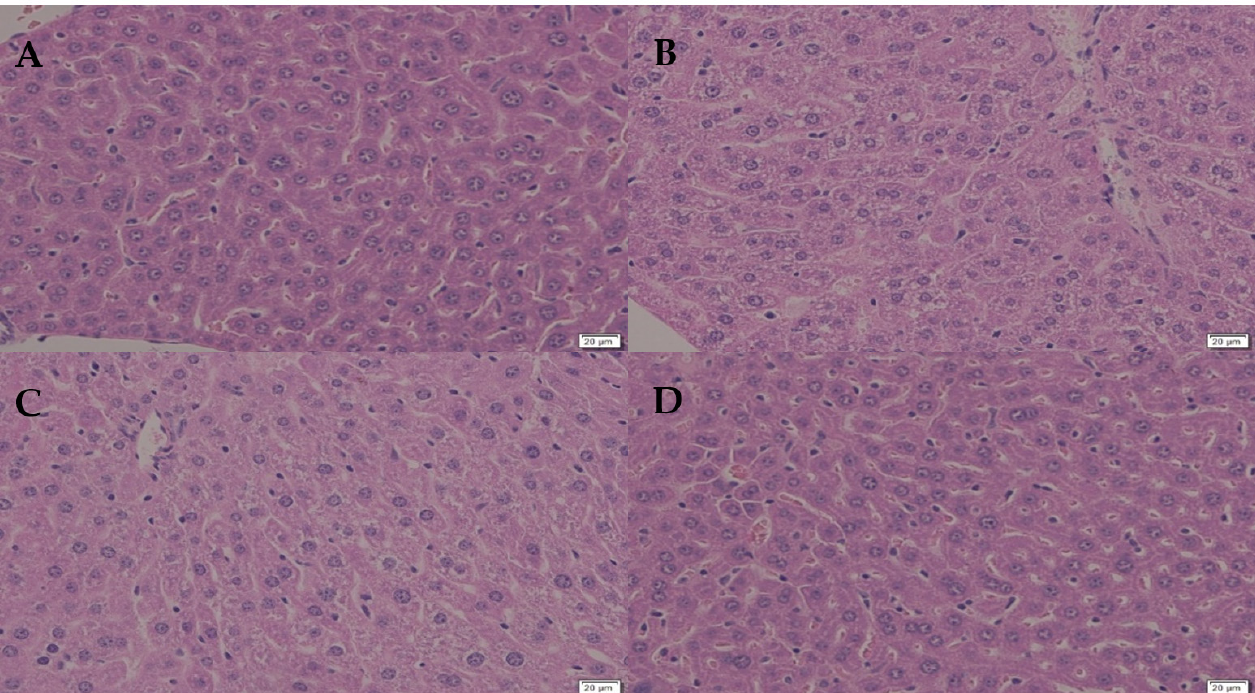
Figure 4. ( A – D ). ( A ): control. ( B ): the effect of olive oil on the hepatocytes. ( C ): the effect of DIMICAN is visible in hepatocytes in not infected animals. ( D ): Ten days after DIMICAN treatment ( A ) hepatocytes were similar as control ( A ). Scale bars are 20 μ m.